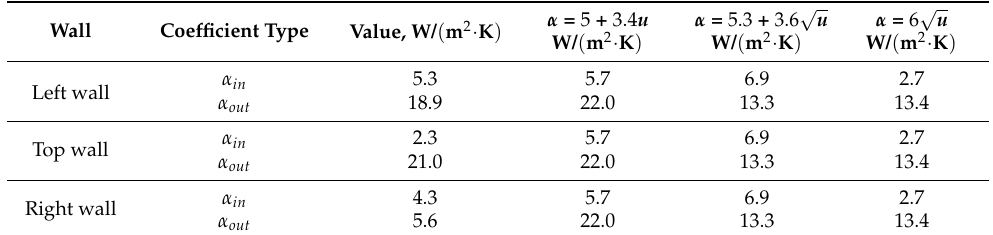
Table 3. Values of the average heat transfer coefficients obtained by the numerical method and by applied formulas obtained experimentally.